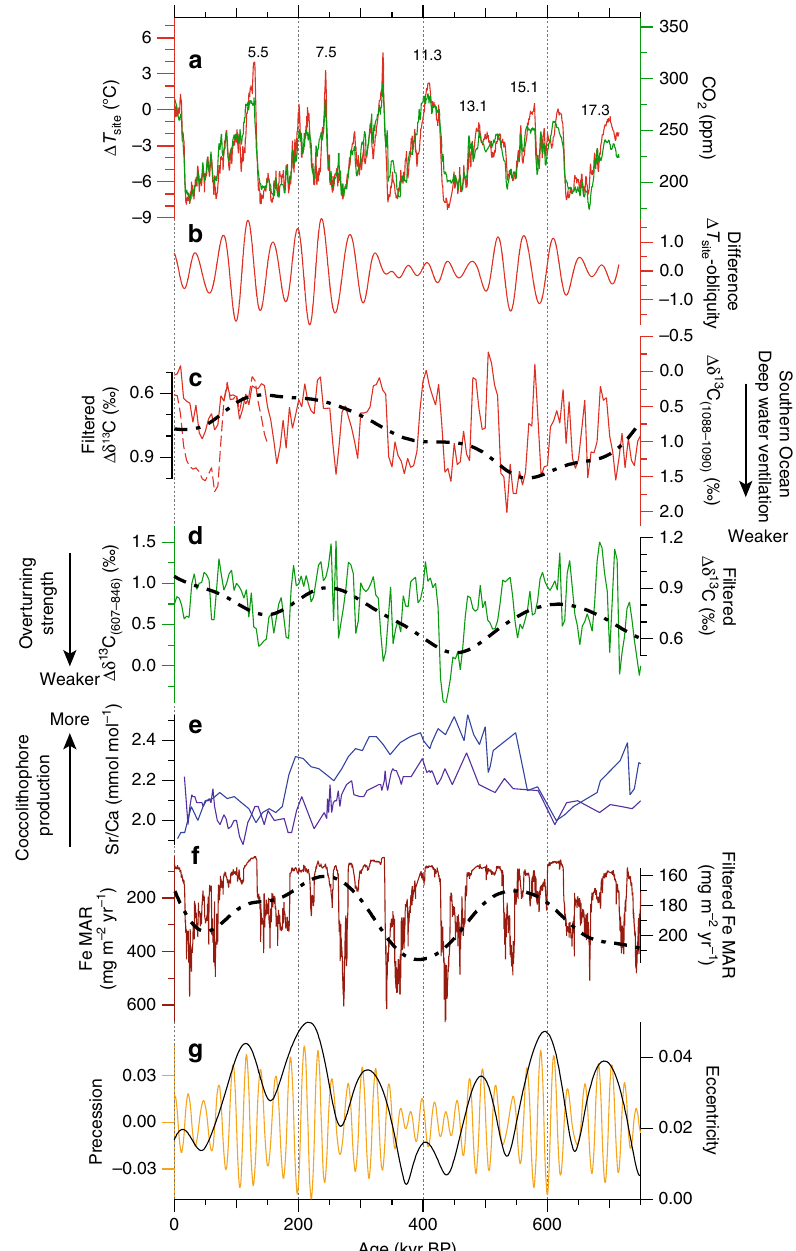
Fig. 5 Link between the 400-kyr phase modulation and the global ocean carbon cycle. a DF Δ T site (red) and the composite atmospheric CO 2 record 32 (green). b The difference between the normalized obliquity component of Δ T site and AMI (same as in Fig. 4g). c The intermediate-to-deep δ 13 C gradient of benthic foraminifera ( Δδ 13 C), a proxy for deep-water ventilation in the Southern Ocean 49 . Δδ 13 C represents the difference in δ 13 C between two cores, speci fi cally those collected at ODP site 1088 (ca. 2100 m water depth) and site 1090 (ca. 3702m water depth) in the South Atlantic Ocean. Dotted red line indicates the Δδ 13 C obtained using C. kullenbergi data at site 1090 and solid red line indicates C. wuellerstor fi data only. d A measure of overturning strength based on δ 13 C gradient 50 between the North Atlantic (ODP site 607) 91 and the tropical Paci fi c Ocean (ODP site 846) 92 . Small gradients (close to zero) imply drastically reduced ventilation of the Atlantic or enhanced ventilation in the Paci fi c 50 . e Sr/Ca of coccolithophores as a proxy for the rate of coccolithophore production in southwestern Indian Ocean (purple line, MD962077) and in the western equatorial Paci fi c (blue line, V28-239) 45 . f Mass accumulation rate (MAR) of iron in the subantarctic Atlantic Ocean (ODP site 1090) 48 . Dashed-dotted black line indicates the long-term trend obtained using a Gaussian fi lter around 0 kyr − 1 with a 0.0045 kyr − 1 bandwidth (i.e with periodicity< 222 kyr removed). g Orbital eccentricity (black) and